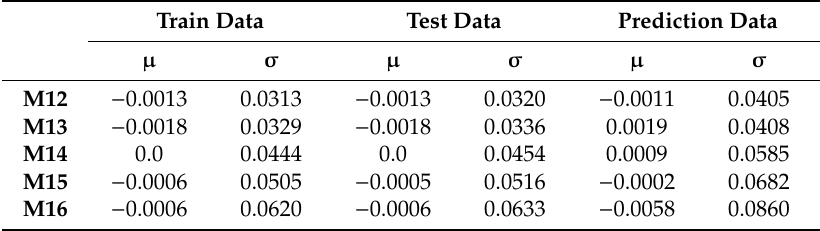
Table 3. The F-C mean and STD of the train and test data, and predicted data for 02 / 21 / 2020 (F-C: di ff erence between FCDN_CRTM BT and CRTM BT; µ : F-C mean bias; σ : corresponding